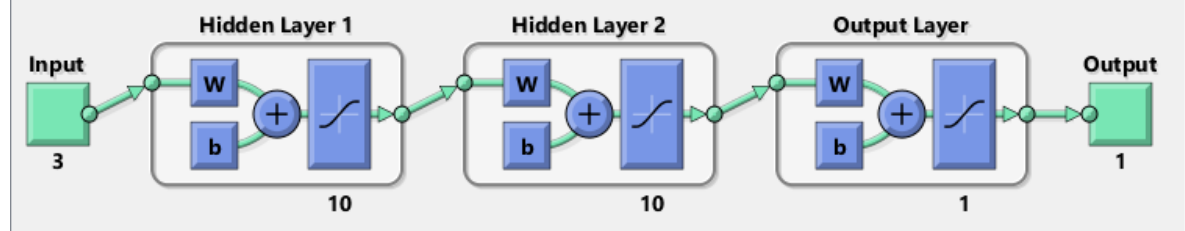
Figure 3. Artificial neural network model consisting of two hidden layers .